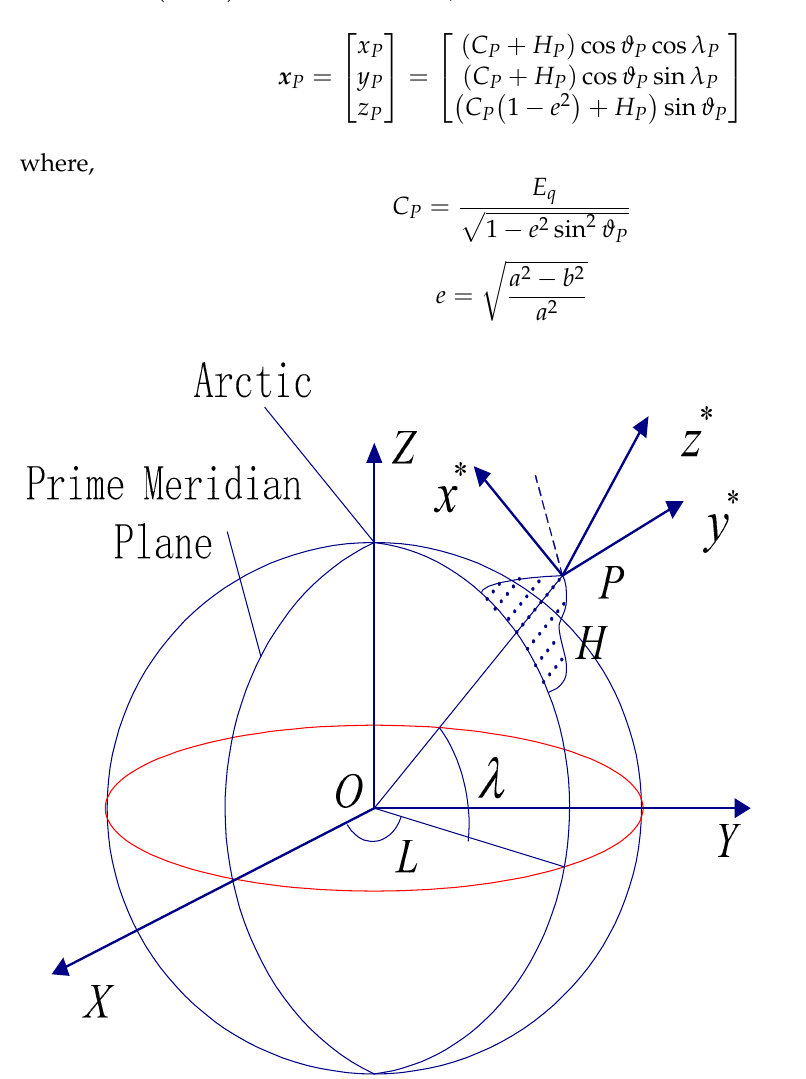
Figure 4. Geodetic coordinate system.